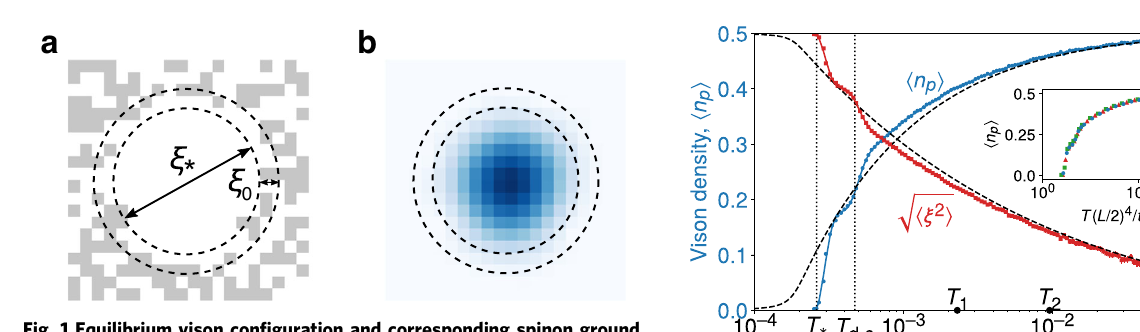
Fig. 1 Equilibrium vison con fi guration and corresponding spinon ground state density. a Vison con fi guration, { n p }. The visons form an empty circular patch surrounded by a disordered background. The inner dashed line corresponds to the saddle point radius ξ * of the effective free energy (3), while the outer dashed line equals the characteristic extent of the spinon wave function, ξ * + ξ 0 . b Ground state spinon density. The data are taken from the MC simulations at T / t s = 10 − 3 for a system of size L 2 = 20 2 with periodic boundary conditions.